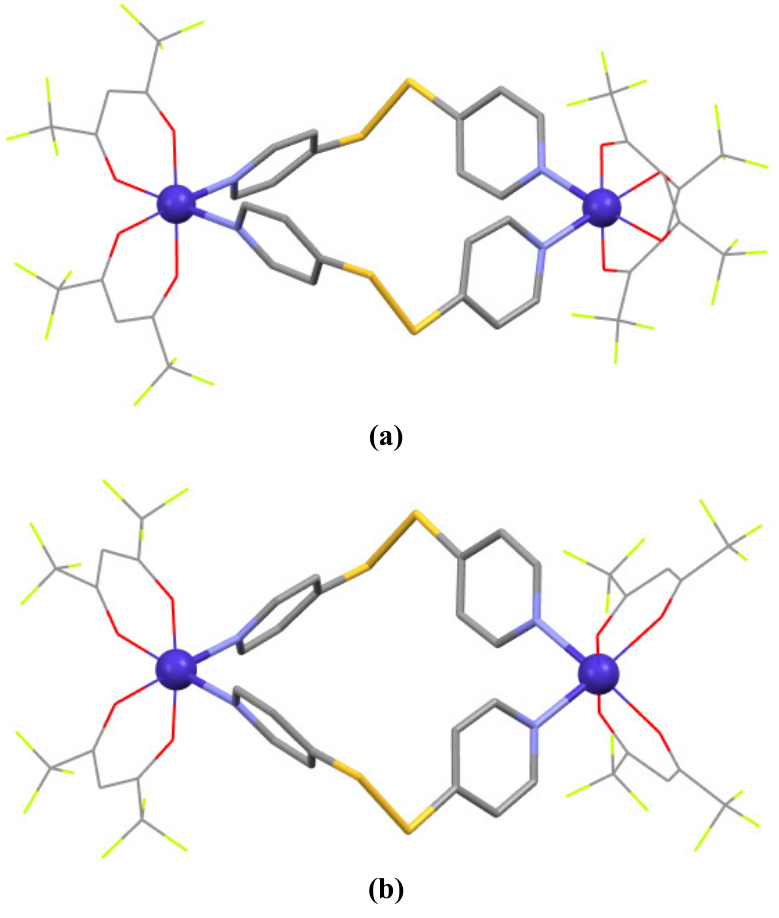
Figure 6. ( a ) Molecular structure of the M form of the dtdp ligands and the Λ configuration of both cis -Co(hfacac) ( b ) Molecular structure of the macrocycle in FEBBOE, also showing the P form of the dtdp ligands. In this complex, one cis -Co(hfacac) the other the right-handed ∆ configuration (see